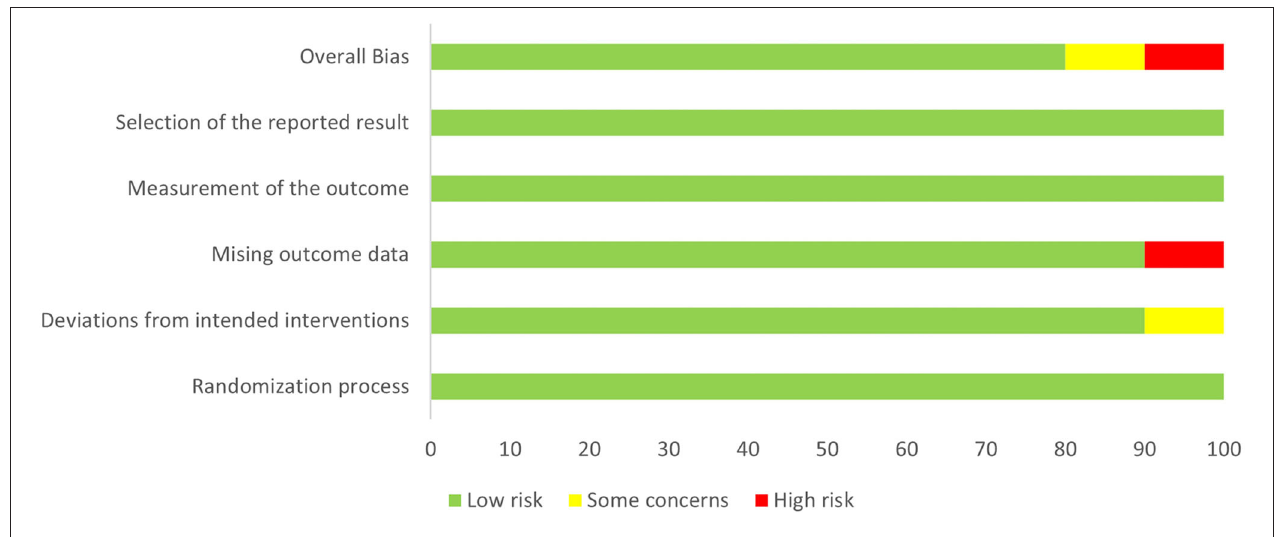
FIGURE 2 | Literature quality evaluation (RoB